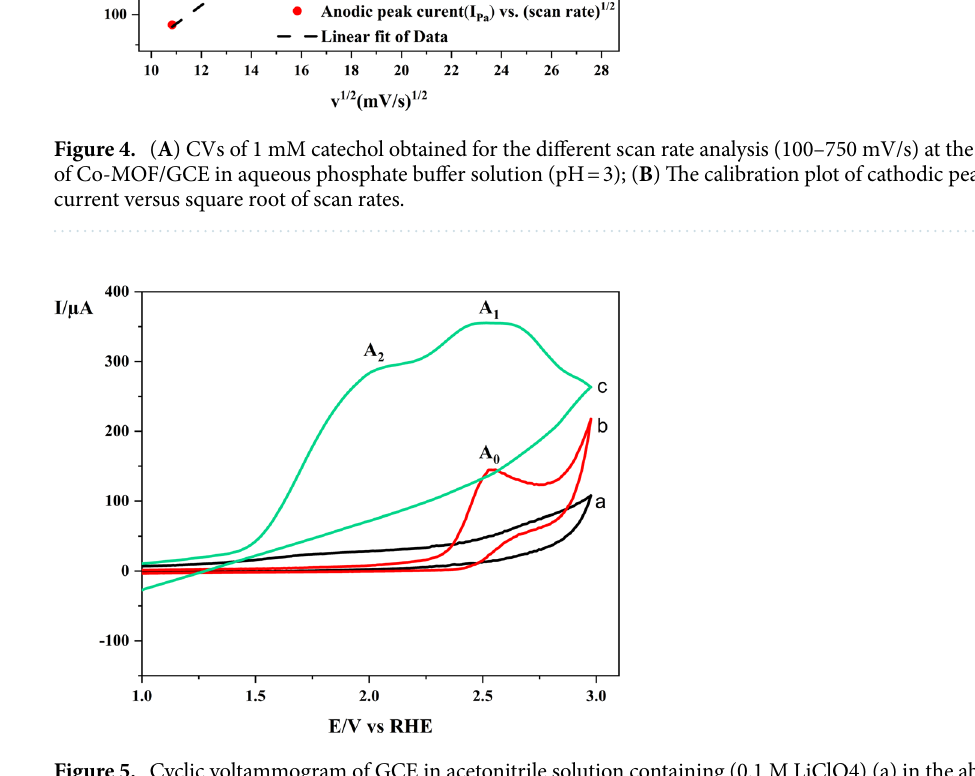
Figure 5. Cyclic voltammogram of GCE in acetonitrile solution containing (0.1 M LiClO4) (a) in the absence of BA; (b) in the presence of 10 mM BA; ( c ) CV of BA at Co-MOF/GCE in the same conditions of b, scan rate: 100